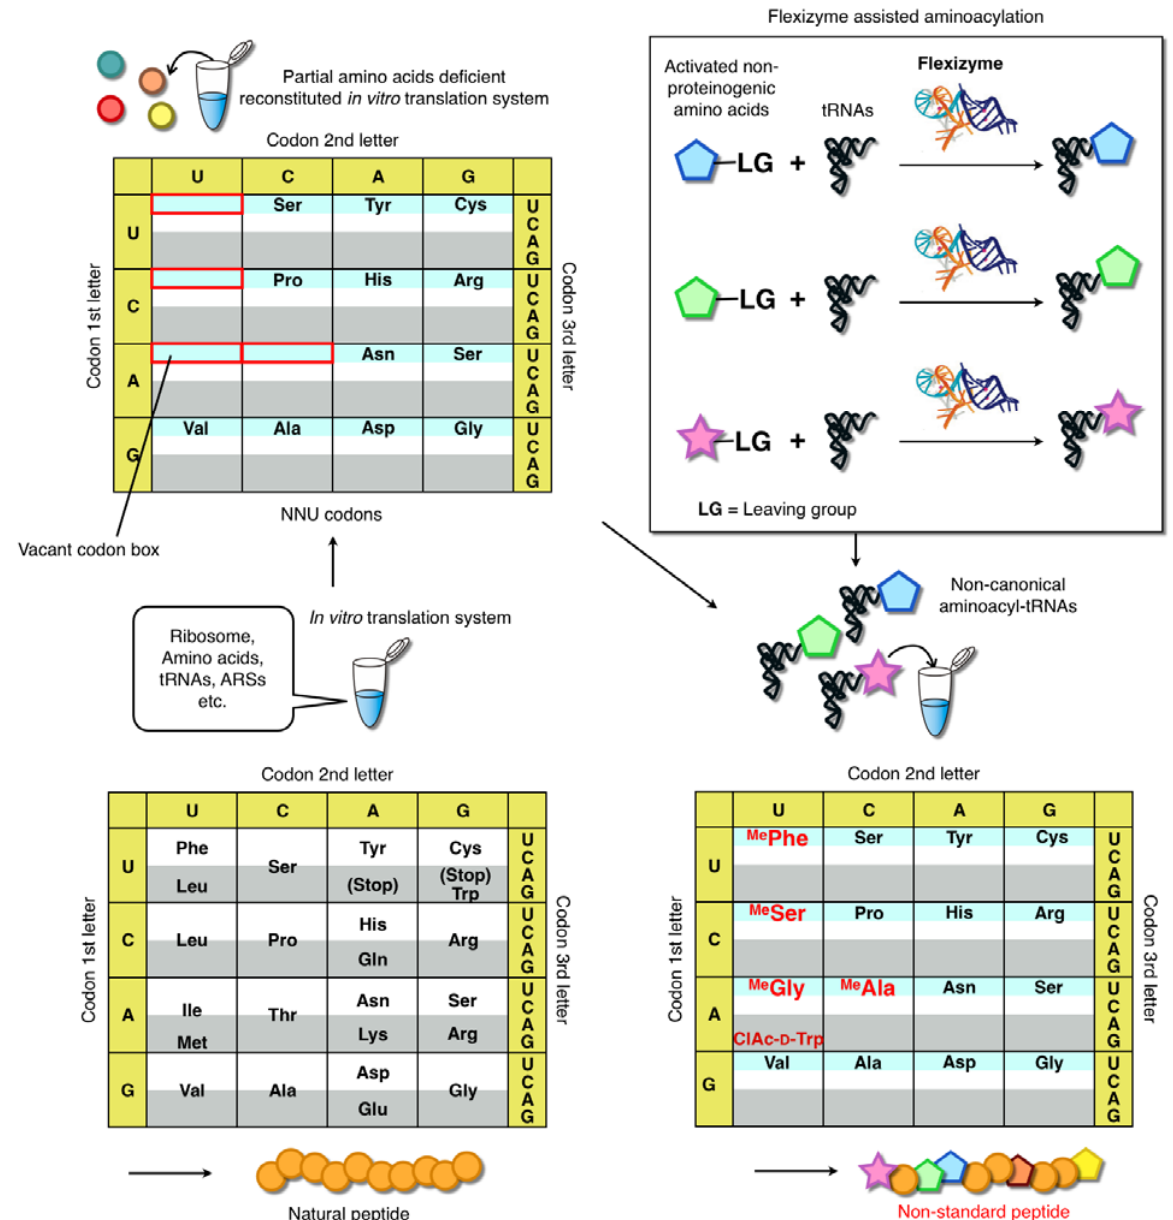
Figure 3. Genetic code reprogramming using the FIT system [22]. Peptides are ribosomally synthesized in this system through the activity of a fully reconstituted in vitro translation reaction. Amino acids or other factors can be omitted from the reaction as desired. The figure depicts a reaction in which 5 canonical amino acids (Phe, Leu, Ile, Thr and Met) have been omitted from the system to create the vacant codons. Addition of the corresponding aminoacyl-tRNAs charged with non-canonical amino acid by flexizymes (in this instance chloroacetyl- D -tryptophane: ClAc- D -Trp and four N- methyl amino acids: Me X) enables for “reprogramming” of codons to ribosomally synthesize peptides that contain the designated non-canonical amino